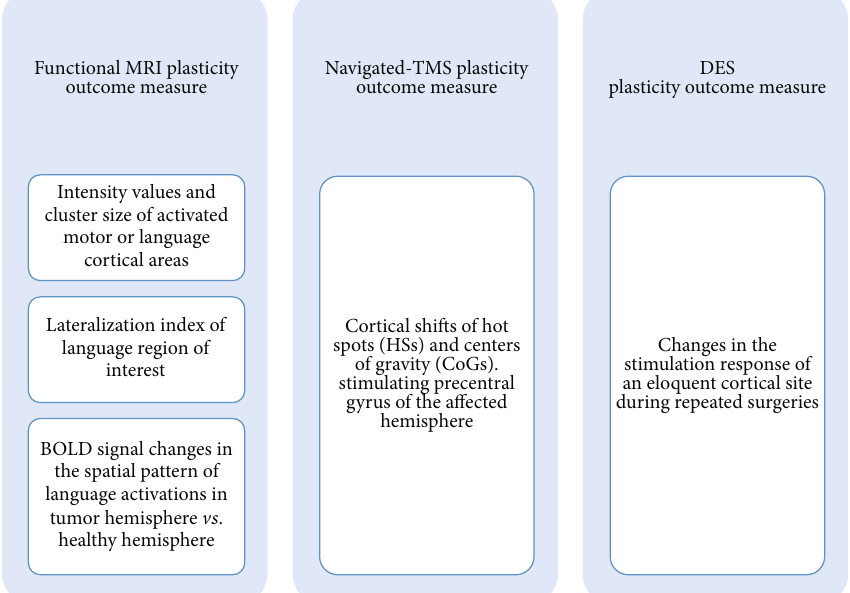
Figure 3: Description of plasticity outcome